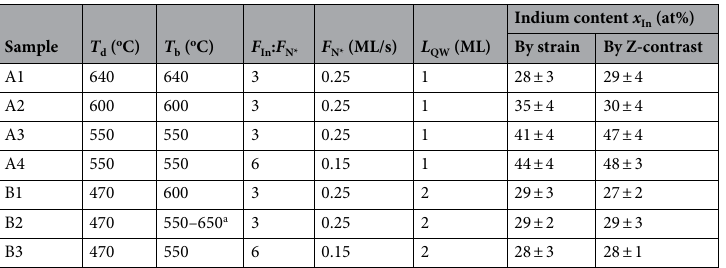
(HAADF) HRSTEM image of sample A3 showing the good MQW periodicity. In the A sample series, the aver- age thickness of the barriers was 38 ± 1 MLs, and in the B sample series 32 ± 2 MLs. TEM diffraction contrast observations revealed that sample A3 exhibited few basal stacking faults (SFs) due to the relatively lower deposi- tion temperature. SFs were not observed in sample A4, albeit growth at the same temperature, probably due to the lower growth rate. Figure 2b,c present atomic resolution Z-contrast HAADF-HRSTEM images from the A sample series, whereby it is seen that in all cases 1 ML QWs are obtained, with excellent crystal structure. The QWs exhibited few steps of ML height; other than that, they were very well confined in 1 ML. In sample A4, the In/N* flux ratio was doubled by lowering the active nitrogen (N*) flux to about a half.